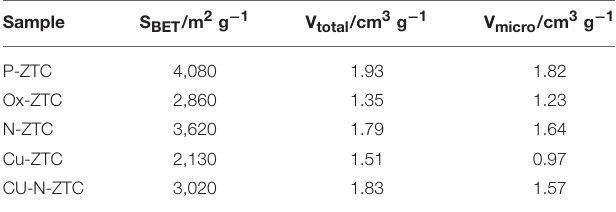
TABLE 2 | Specific surface area and pore volumes of ZTC